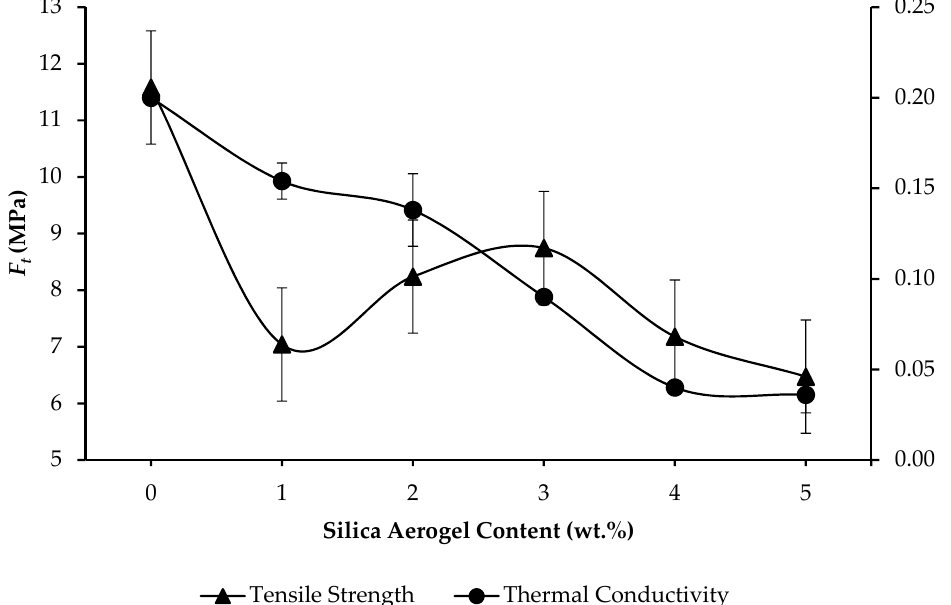
Figure 8. Tensile strength ( F t ) and thermal conductivity ( k ) for the composite insulation materials.